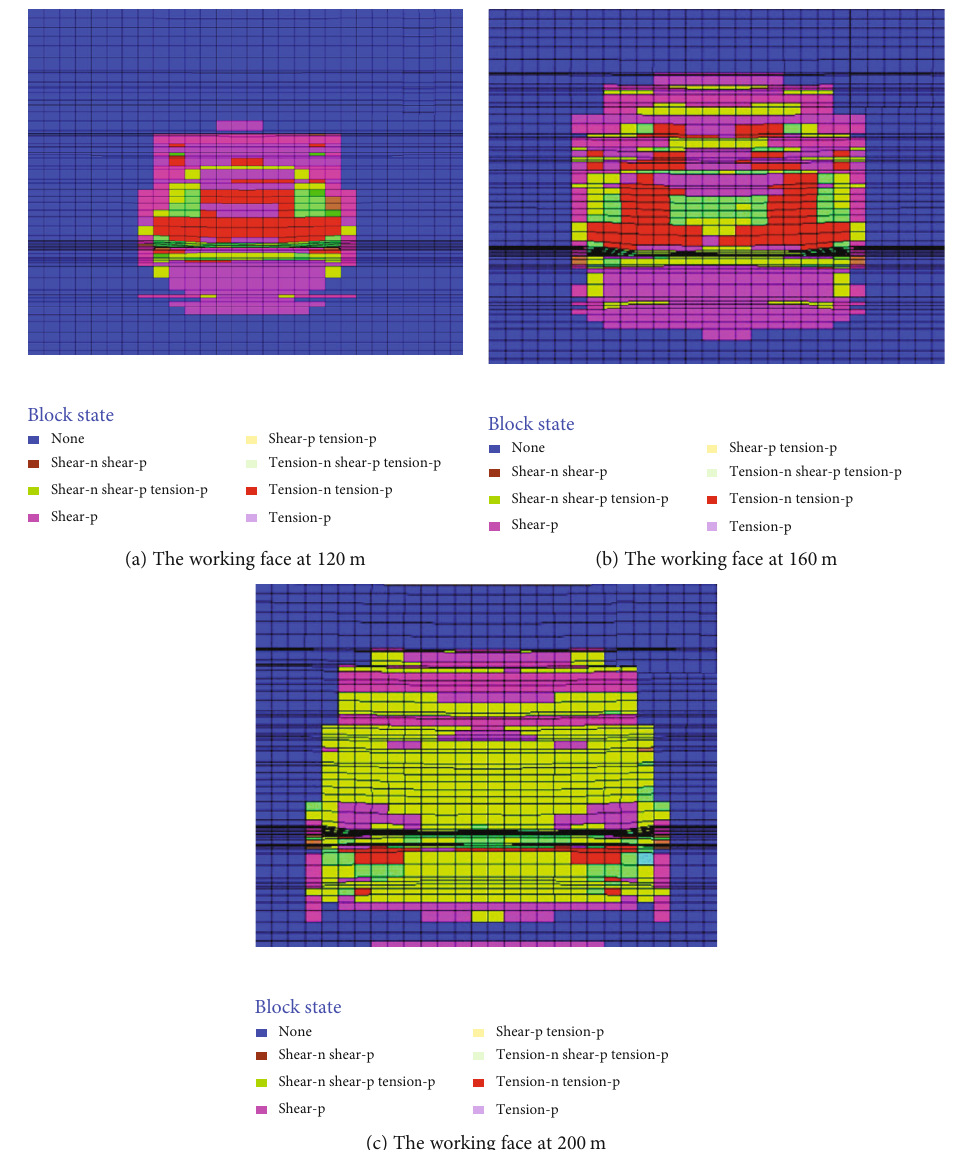
Figure 12: Plastic zone